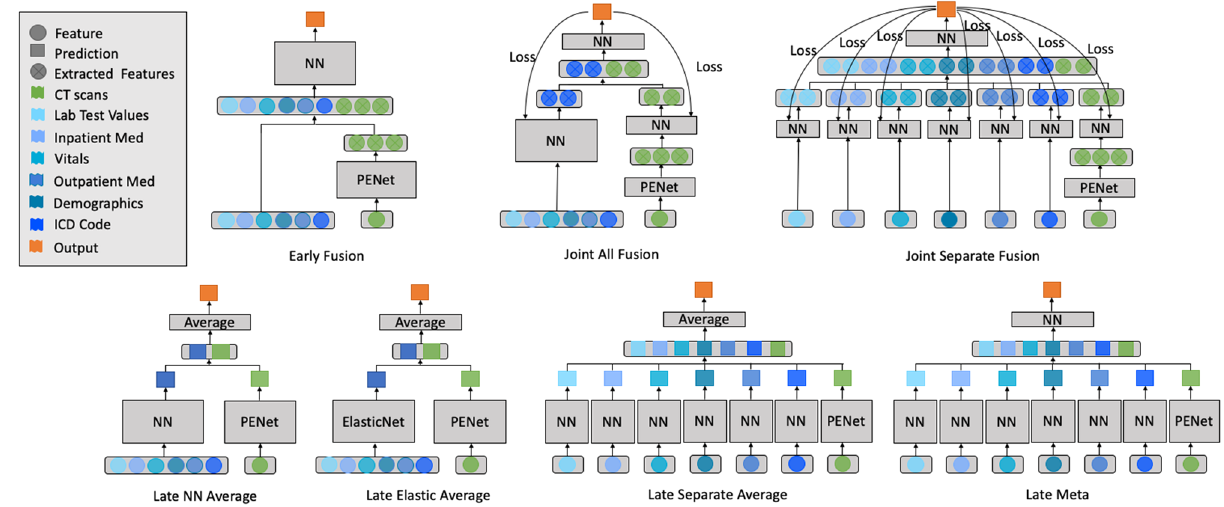
Figure 2. Fusion model architectures. The 7 different fusion architectures used in this study, including ( A ) Early Fusion, ( B ) Joint All Fusion, ( C ) Joint Separate Fusion, ( D ) Late NN Average, ( E ) Late Elastic Average, ( F ) Late Separate Average and ( G ) Late Meta. Each input feature modality is color coded. Detailed definition of each model architecture is described in the Methods.